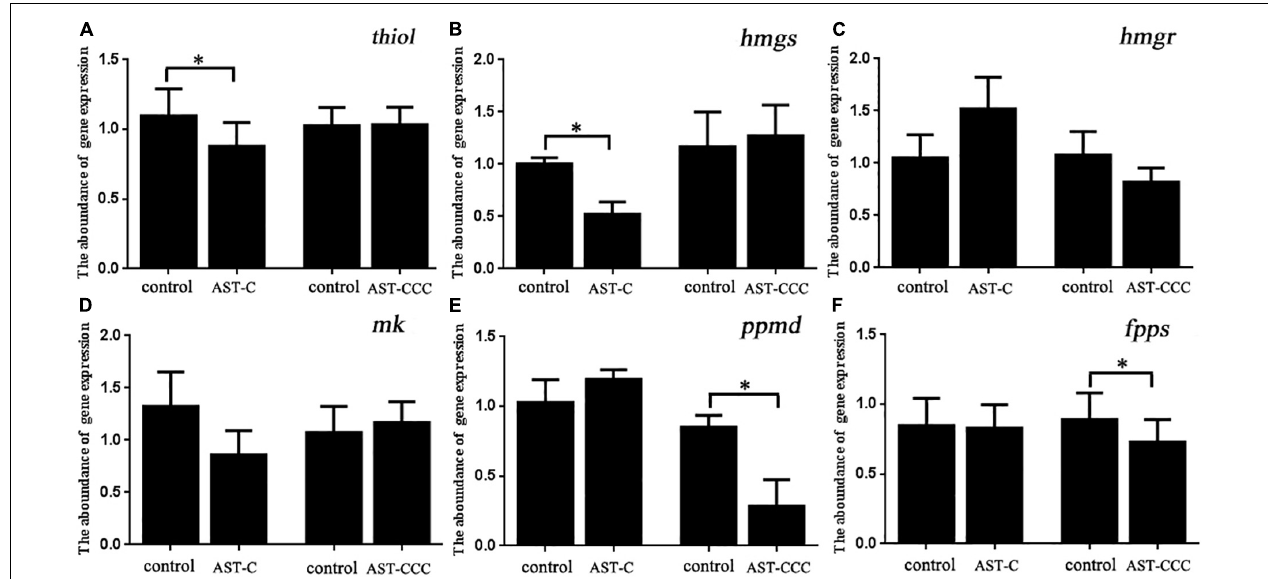
FIGURE 8 | In vitro effects of Scypa AST-C and Scypa AST-CCC on the abundance of MF biosynthetic enzyme genes in the mandibular organ. (A) thiol : acetoacetyl-CoA thiolase ; (B) hmgs : 3-hydroxy-3-methylglutaryl-CoA synthase ; (C) hmgr : 3-hydroxy-3-methylglutaryl-CoA reductase ; (D) mk : mevalonate kinase ; (E) ppmd : diphosphomevalonate decarboxylase ; (F) fpps : farnesyl diphosphate synthase . Asterisks “ ∗ ” on the error bars indicates significant difference from the control ( P <